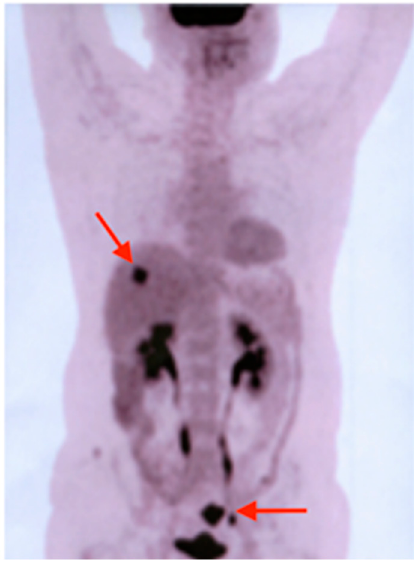
Figure 6. MIP image of F18-FDG PET-CT revealing a lesion in the sigmoid colon (lower-right red arrow) and a lesion of 21 mm in the VIIth liver segment (upper-left red arrow), consisting of a colon malignant tumor with liver metastases.